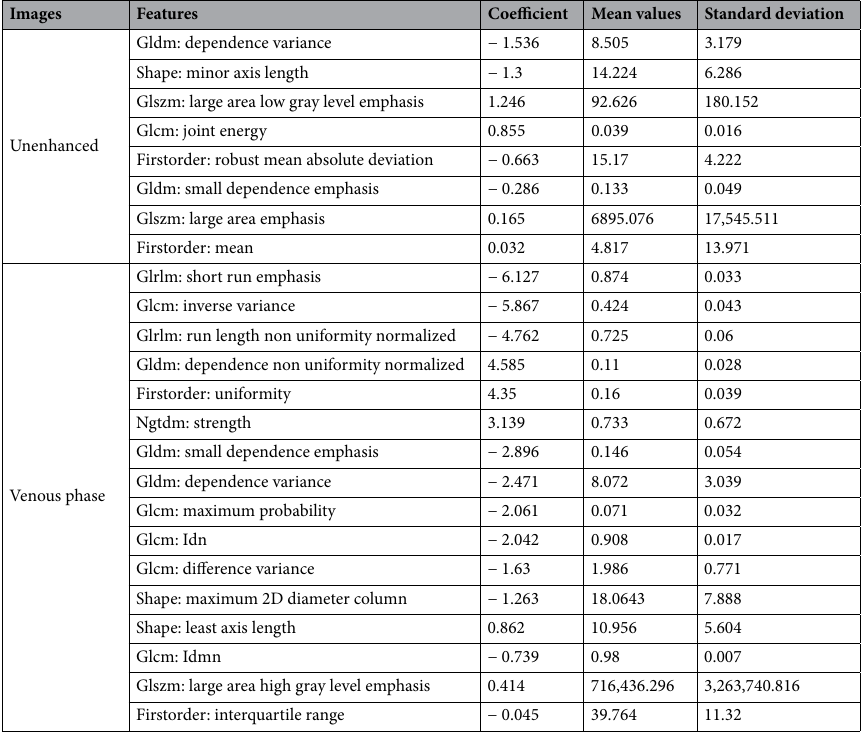
Table 2. Selected radiomic features in unenhanced and venous phase contrast-enhanced CT.